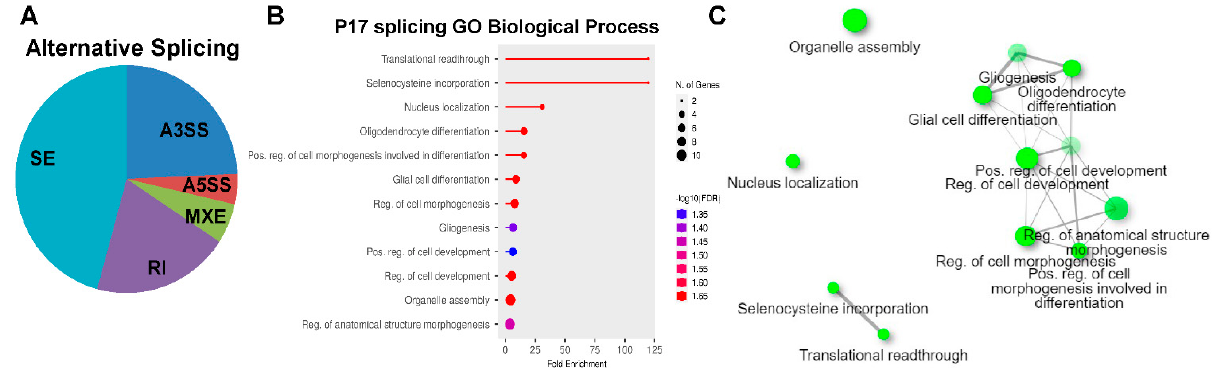
Figure 6. RBM8A is a moderate regulator of AS at P17. ( A ) MISO was used to AS events between the cKO and control datasets. RBM8A was found to be a moderate regulator of alternative splicing, as 62 mRNAs show significant changes in the AS in the brains of Nes-Cre; Rbm8a f/+ mice at P17. A3SS: alternative 3 ′ splice site; A5SS: alternative 5 ′ splice site; MXE: mutually exclusive exons; RI: retained intron; SE: skipped exon. ( B ) GO analysis of AS genes at P17. ( C ) Network plot of GO analysis of biological process on AS genes at P17.